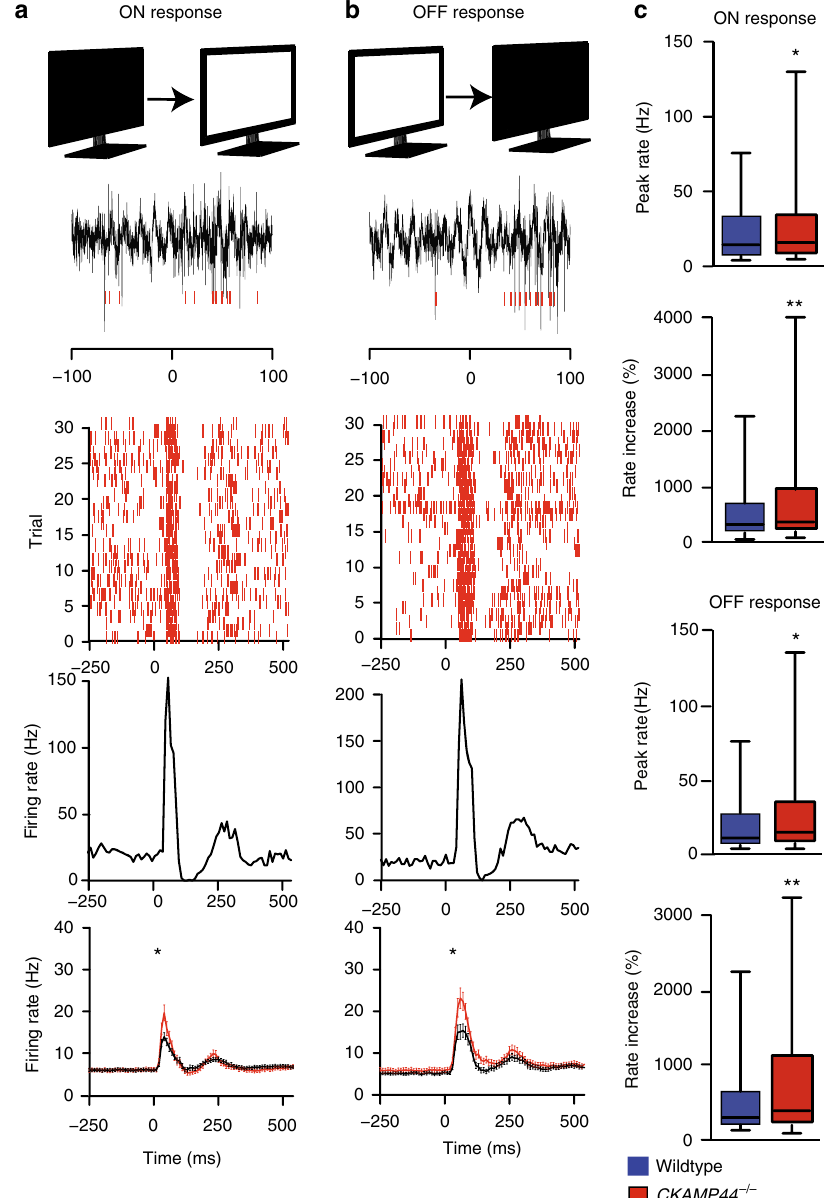
Fig. 5 CKAMP44 decreases peak fi ring rate of ON and OFF-responses in vivo. a ON-response amplitude is signi fi cantly higher in CKAMP44 − / − than in wildtype mice. ON-responses were observed brie fl y after increasing the light intensity of the monitor ( n = 542 dLGN neurons in 6 wildtype and 430 dLGN neurons in 6 CKAMP 44 − / − mice; mean ± SEM). b Deletion of CKAMP44 increases also the OFF-response amplitude (mean ± SEM, Mann – Whitney test) ( n = 309 dLGN neurons in 6 wildtype and 285 dLGN neurons in 6 CKAMP44 − / − mice). a , b Raw traces of tetrode recordings are shown on the top, raster and peristimulus time histograms in the middle and average ON- and OFF-responses at the bottom. Red bars indicate spikes of dLGN neurons. c Quanti fi cation of the peak fi ring rate and the rate increase for ON- and OFF-responses (box-and-whisker plots showing the median, IQR and 5 – 95% range, Mann – Whitney test). * p < 0.05, ** p < 0.01, *** p <